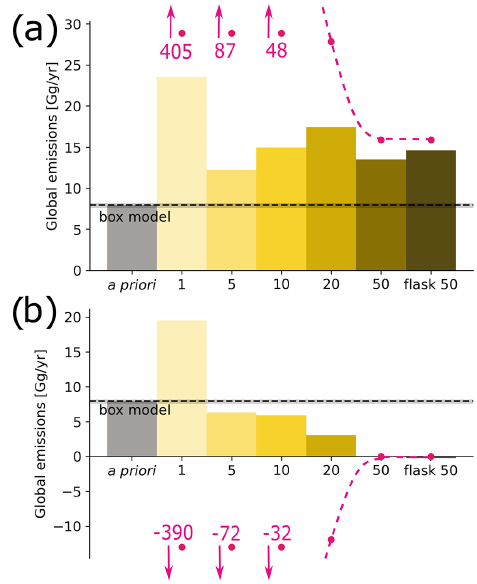
Figure A5. Global SF 6 emissions using the GDB method shown for two sensitivity tests, where a uniform bias of (a) − 0.05 and (b) + 0.05ppt is added to every grid cell of the global mixing ratio fields. Results are shown for backward simulation periods between 1 and 50d, and for a 50d backward simulation case, where addi- tionally to continuous measurements also flask measurements were included in the inversion. The dashed pink lines represent the ex- pected relationship between the baseline bias and a resulting emis- sion bias if a global box model was used and the bias attributed solely to emissions in different periods. For these two sensitivity tests, a priori uncertainties were set to